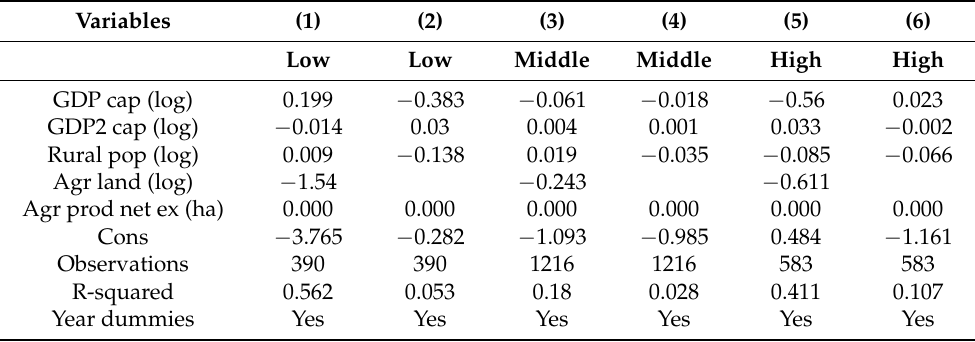
Table A2. Long run, income clusters, net agricultural exports as additional control